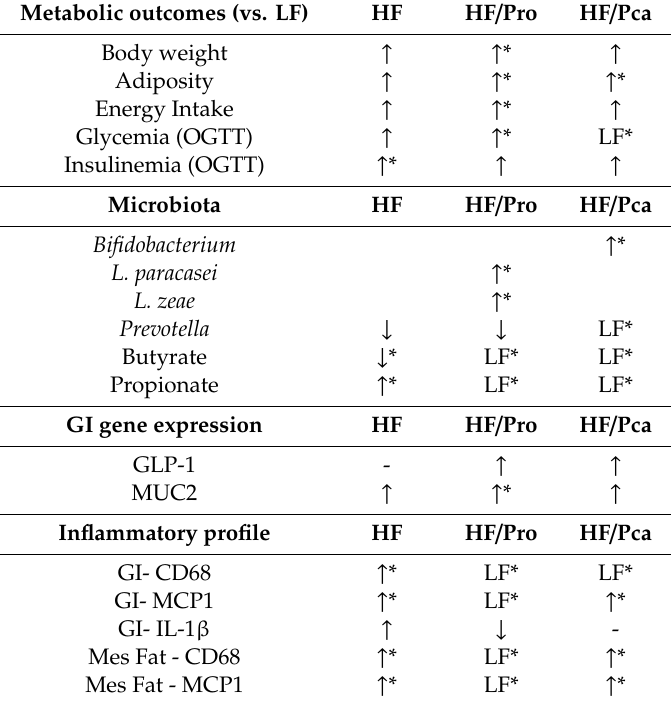
Table 1. Summary of the changes observed in HF, HF / Pro and HF / Pca rats in comparison to the LF control